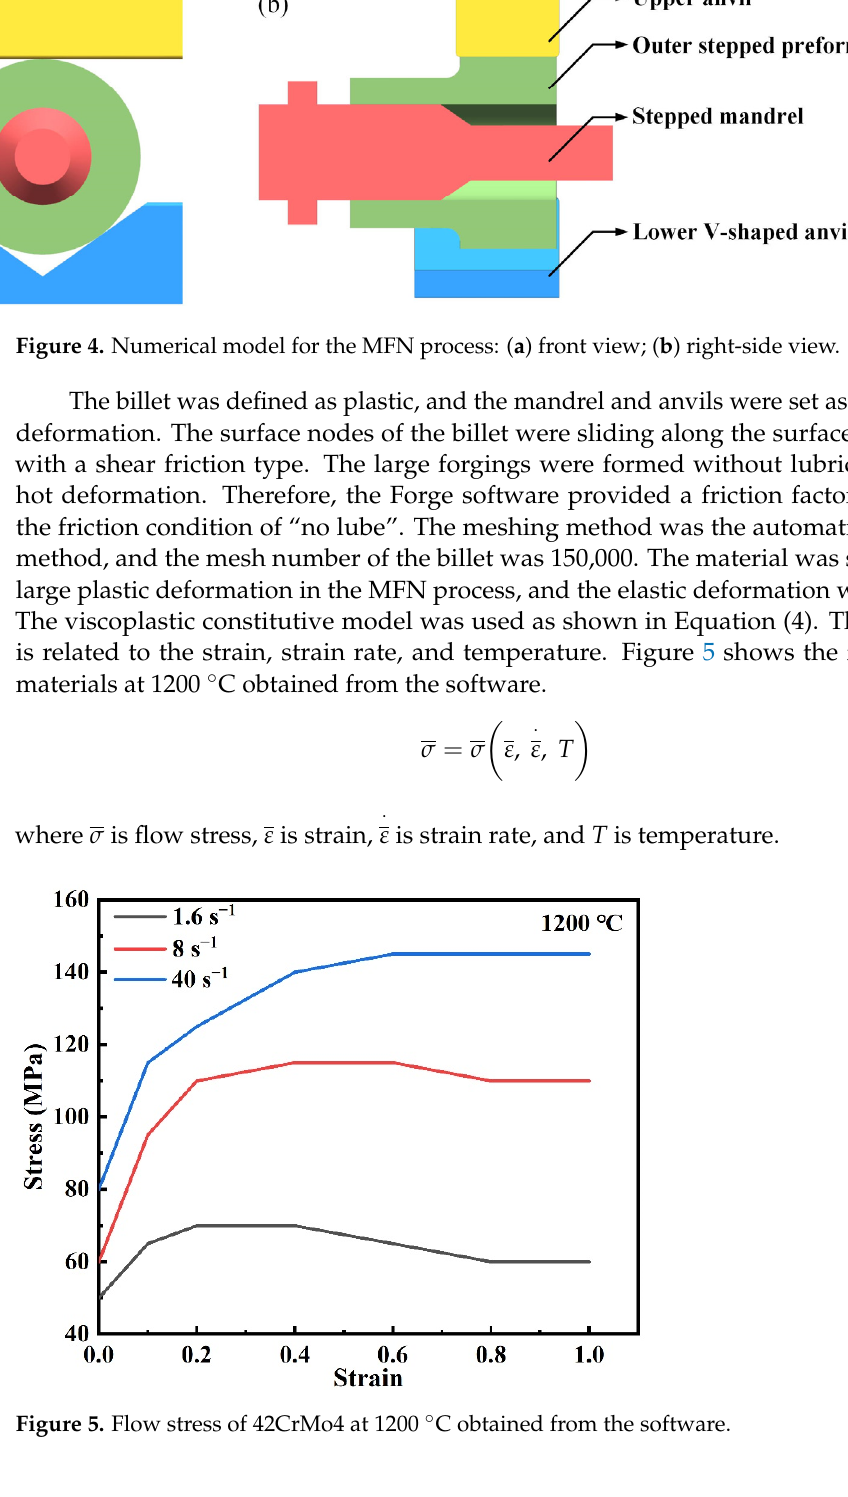
Figure 3. Sizes of target forging and preform (unit: mm): ( a ) target forging; ( b ) K2 preform.